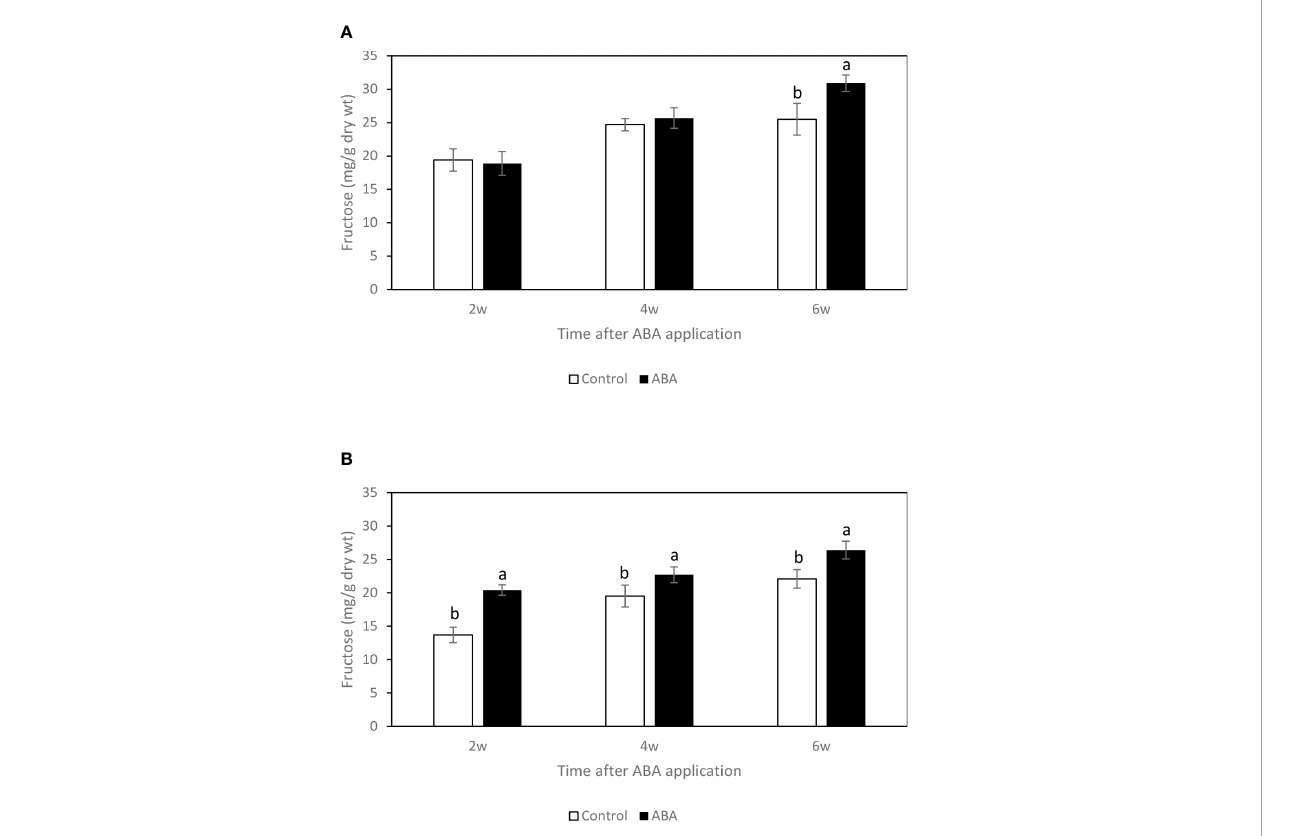
FIGURE 2 Effect of ABA on the bud concentrations of fructose in greenhouse-grown grapevines (A) ’ Chambourcin ’ and (B) ‘ Cabernet franc ’ . Bars with different letters are signi fi cantly different at p ≤ 0.05. (n = 4). Standard errors are